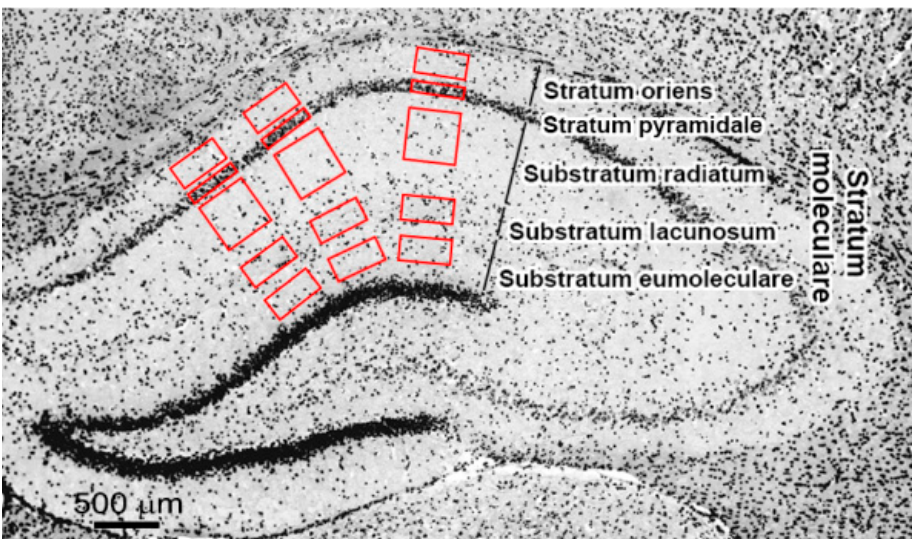
Figure 7. Scheme of calculation of NeuN+, GFAP+, Iba1+, NG2+ cells and MBP-positive area in layers of hippocampus counting to quantify severity of the ischemic lesion in experimental animals. The brain section painted DAPI (gray scale, invert color). Red boxes–regions of interest.